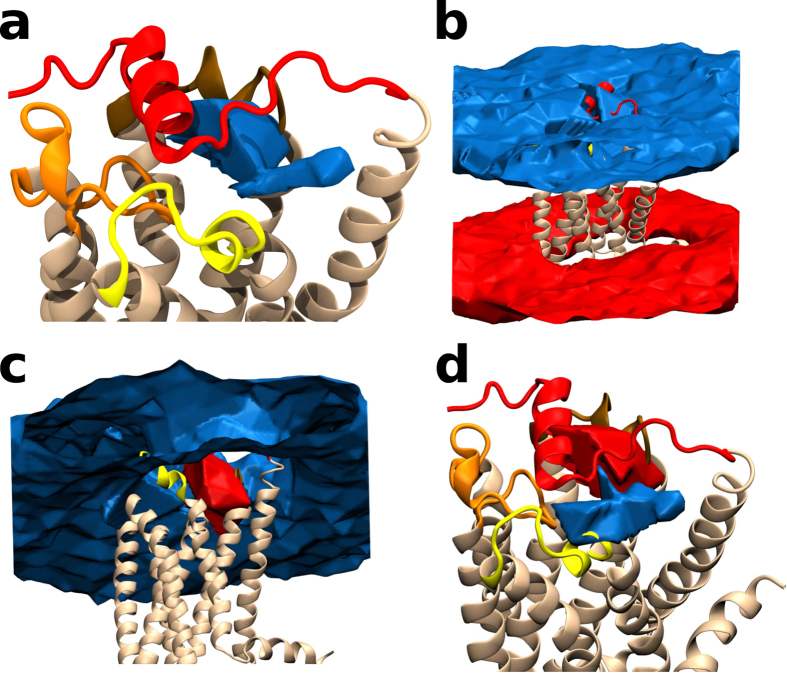
Free energy isosurface of the binding process.(a) The energy surface (blue) of the pathway of ligand entry from the “membrane vestibule” between TMs 1 and 7 and the orthosteric binding cavity. The isosurface is shown at 1 KbT above the minimum (the crystal-bound pose). (b) The MSM eigenvector structure shows the transitions occurring for the slowest process. Transitions are shown from one state (blue blob) to the other (red blob). The slowest relaxation is the flipping of ML056 between the bilayers (100 microseconds). (c) The transition from the bulk upper membrane leaflet to the “membrane vestibule” (1–10 microseconds). (d) The transition between the “membrane vestibule” and the bound state (less than 1 microsecond).